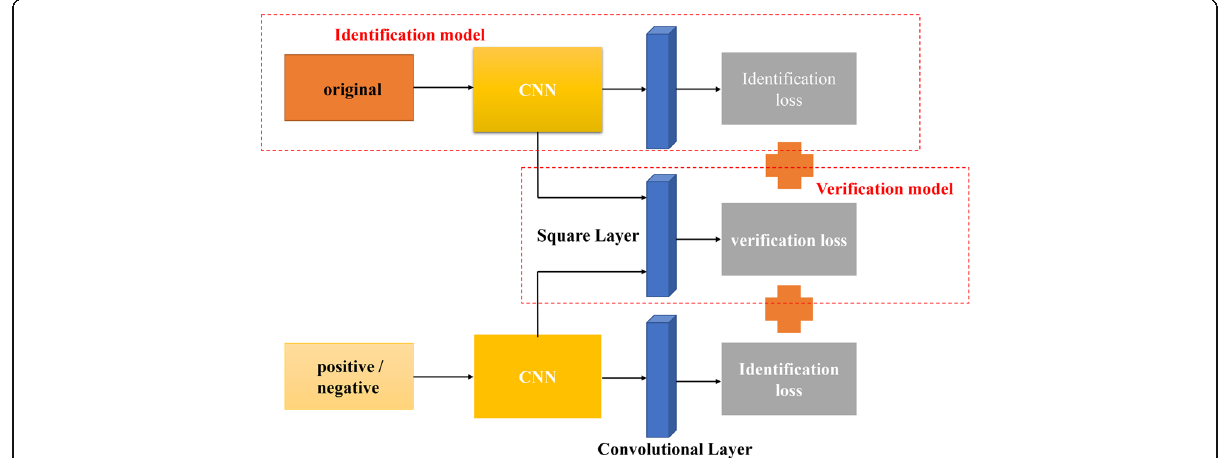
Fig. 1 The architecture of the Siamese CNN. The network takes a pair of images as input. The original image is sent to one CNN channel while the positive image (from the same scene class) or the negative one (from the different scene class) is sent to the other CNN channel simultaneously. The two parameter-sharing CNNs are exploited to process the input images and extract their features. The nonparametric square layer is used for similarity estimation based on the extracted features of the input pair. At the end of the architecture combines the identification (classification) loss and verification (similarity)